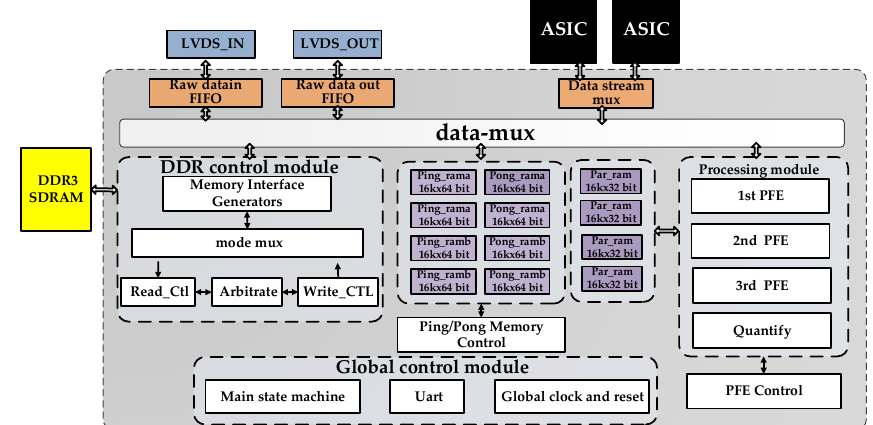
Figure 13. Block diagram of the SAR imaging system.